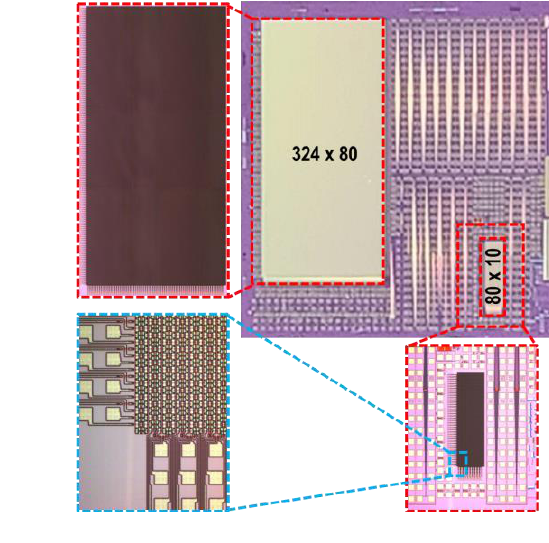
Figure 14. Bump bonding for the first layer: ( a ) pad array diagram; ( b ) layout image.